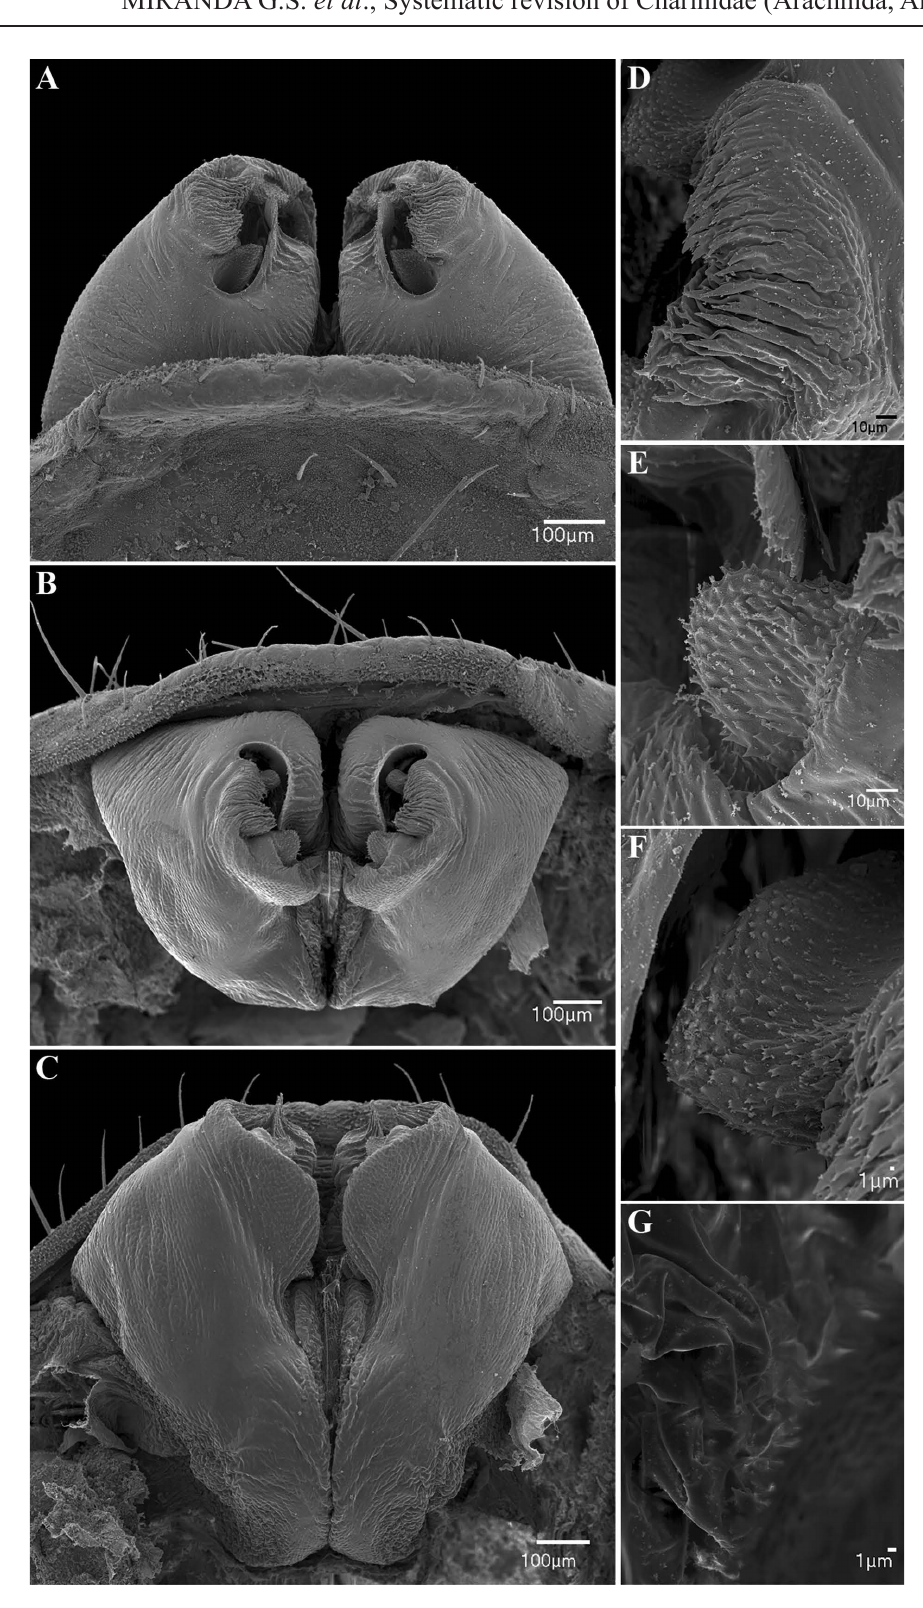
Fig. 133. Sarax yayukae Rahmadi, Harvey & Kojima, 2010 (AMCC [LP 12109]), male gonopod. A . Ventral view. B . Posterior view. C . Dorsal view. D . Sinistral side of gonopod. E . Dorsal lobe. F . Processus internus. G . Internal region of fistula without spiny